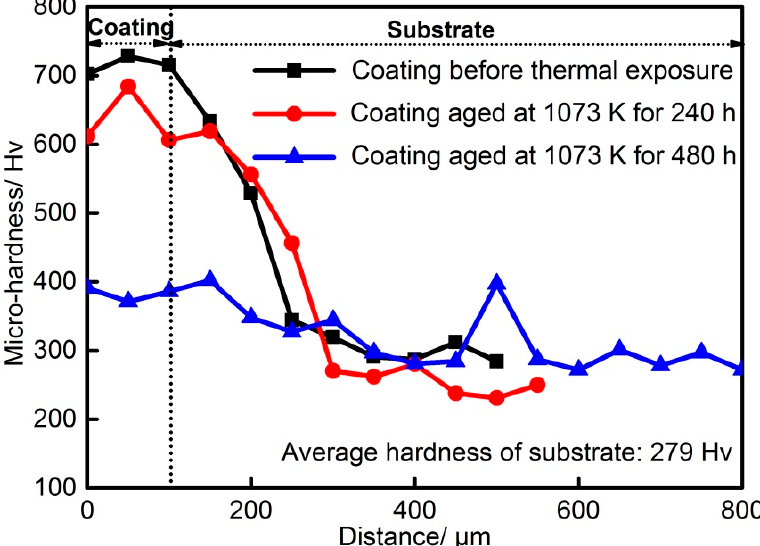
Figure 12. Vickers hardness distribution across the cross-section of the nonaged and aged coatings.